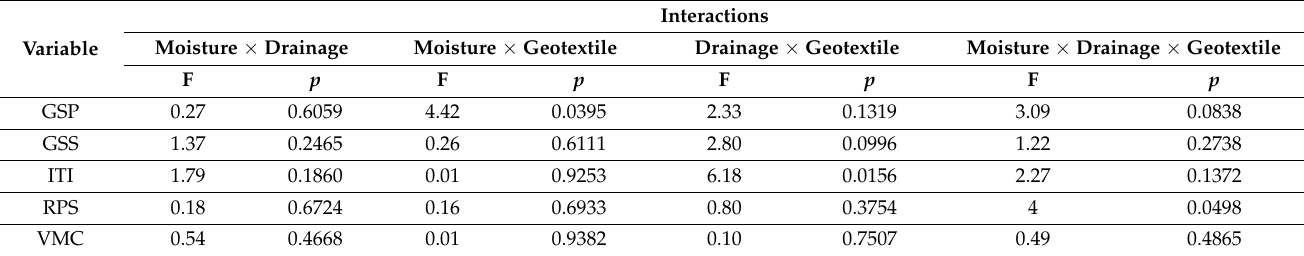
Table 3. F and p -values of interactions between factors: moisture × drainage, moisture × geotextile, drainage × geotextile and moisture × drainage × geotextile over the five variables (GSP, GSS, ITI, RPS, VMC).